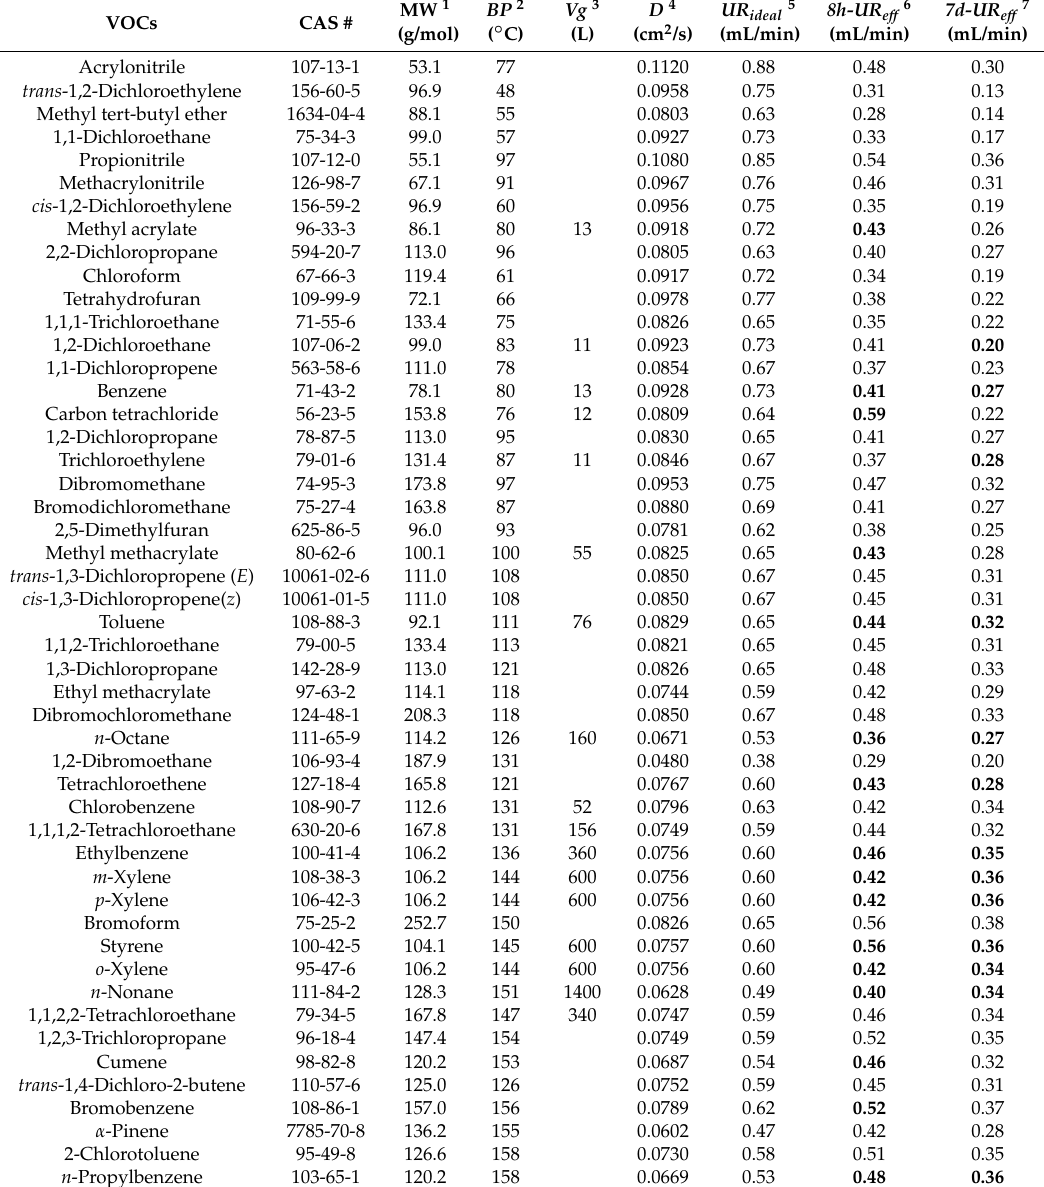
Table 2. Physiochemical properties and uptake rates of 75 common volatile organic compounds